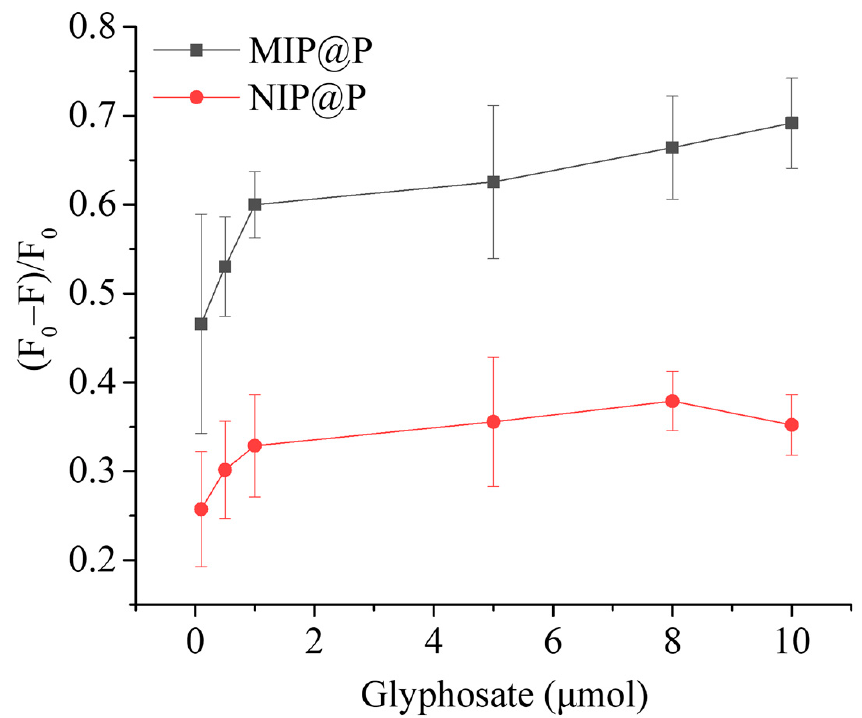
Figure 4. Fluorescence-responsive behaviors of MIP@P and NIP@P when compared to different amounts of glyphosate.